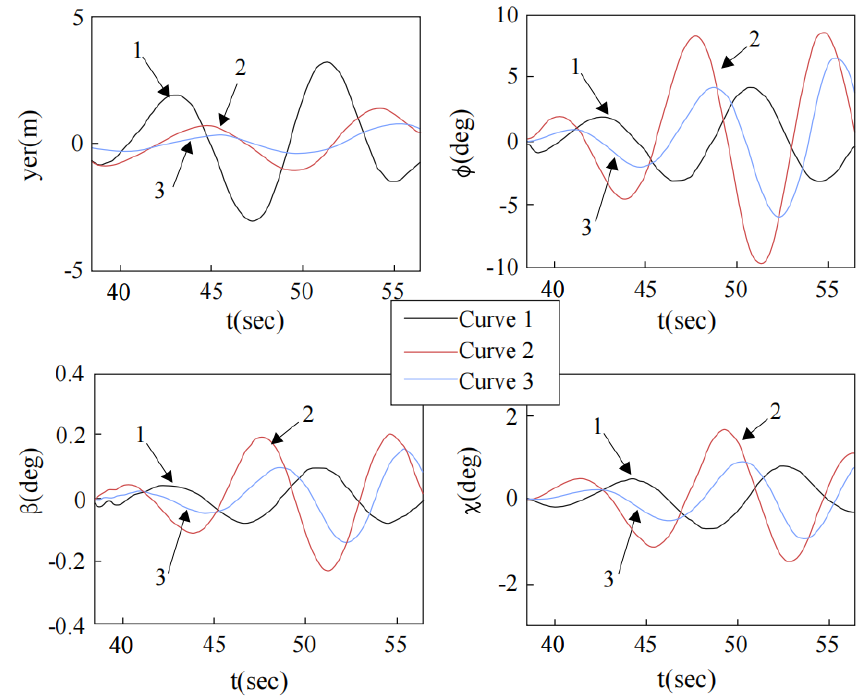
Figure 43. The deck motion compensation curves under inertial tracking strategies with different T values.